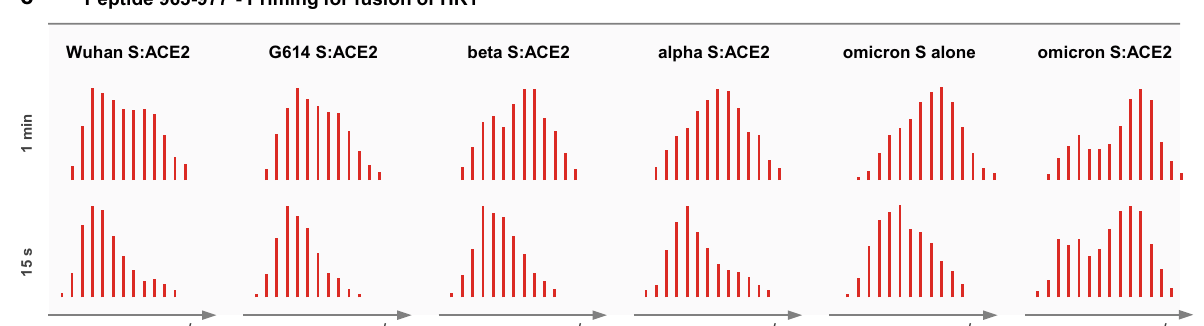
(962 – 982) manifesting HDX bimodality is framed in grey. c The bimodal isotopic envelopesofamodelpeptideoftheHR1region962 – 982areshownat15sand1min time points for spike (S) variants in the ACE2-bound state and for omicron spike alone, to exemplify the priming for fusion upon receptor engagement. Bimodal envelopes manifest in omicron spike also in the absence of ACE2, indicating it as pre-primed for